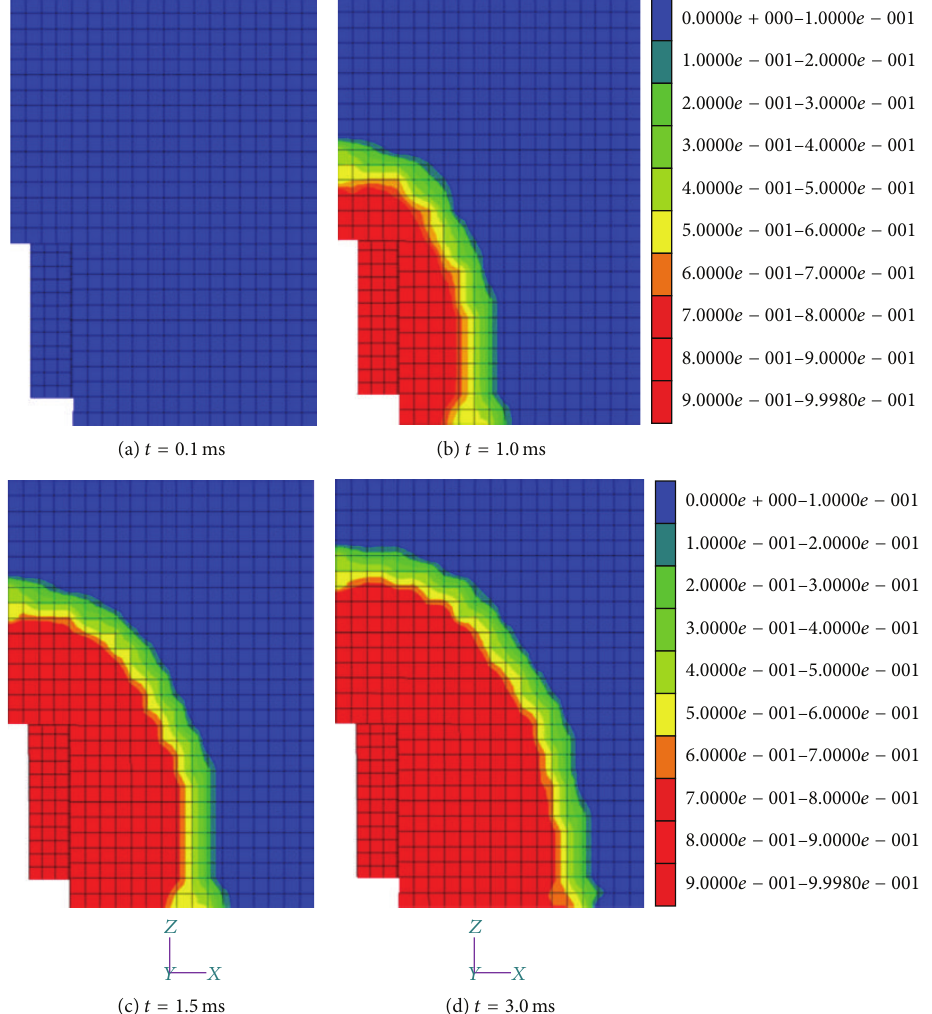
Figure 7: Damage growth along the height